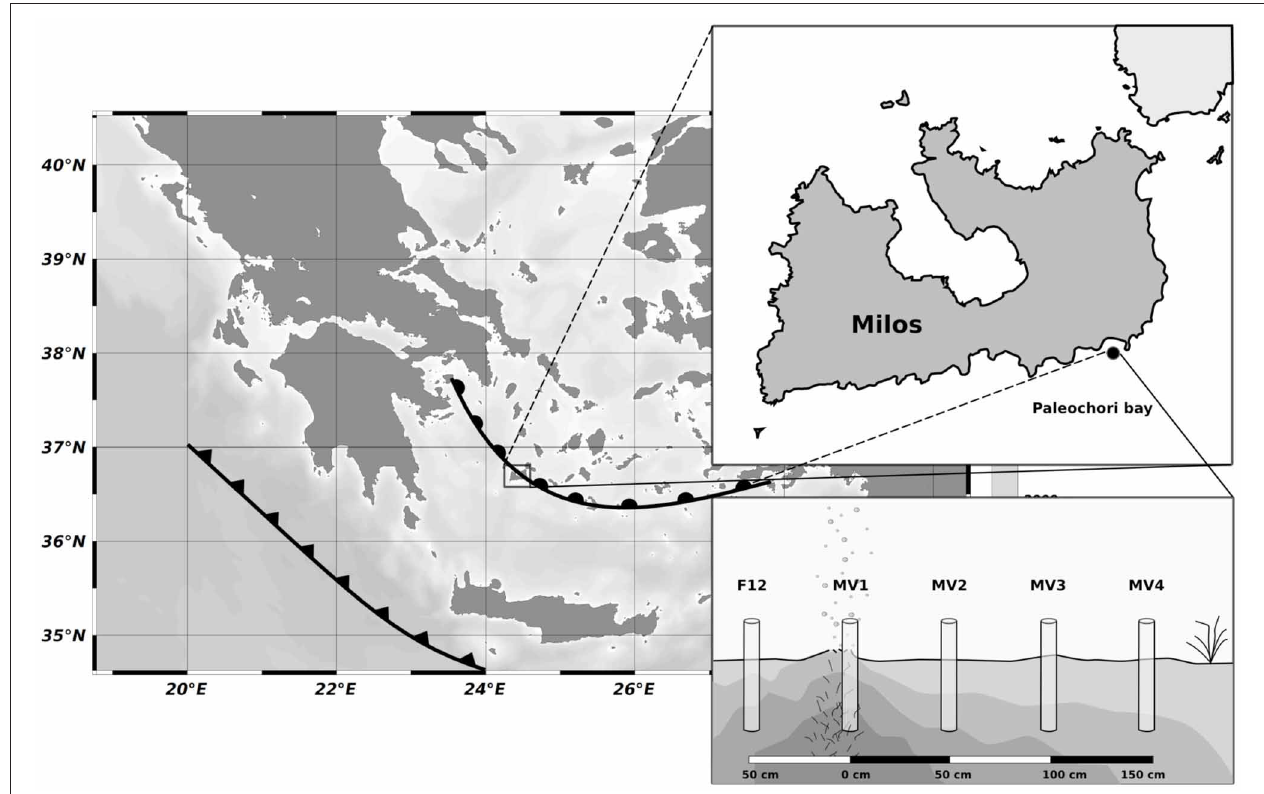
FIGURE 1 | Map showing the position of Milos (Greece) respect to the Hellenic back-arc (circles) and Hellenic Fault (triangles), the location of Paleochori Bay and the sampling strategy along the transect. Cores were placed at interval of 50cm moving away from the vent orifice.